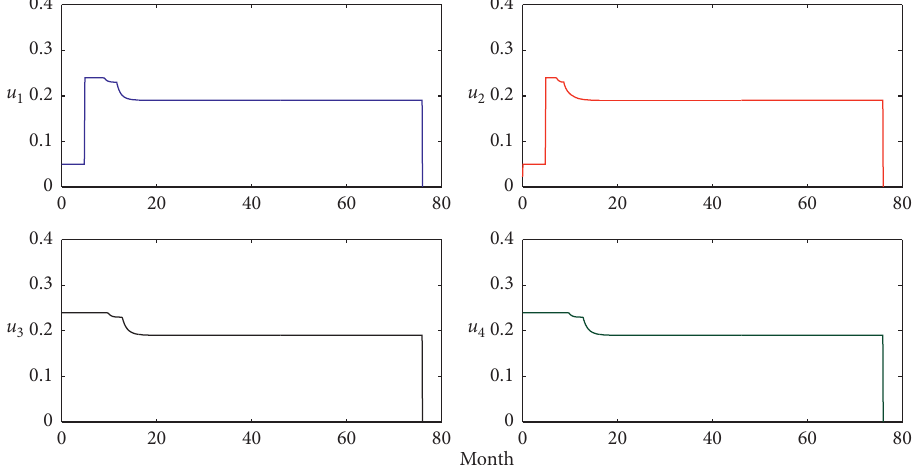
, i � 1 , 2 , 3 , 4, of Strategy i